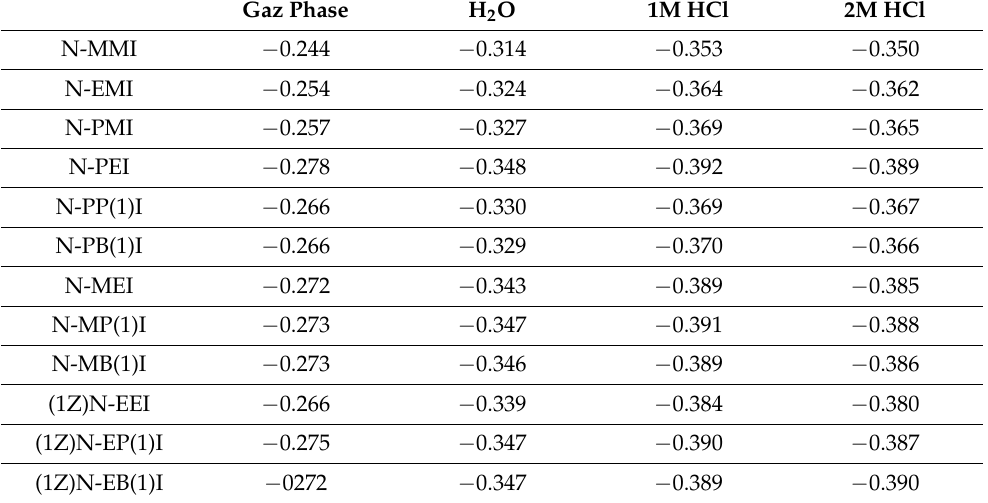
Table 2. Partial charges of the N atoms of the aliphatic Schiff bases under study determined by Mulliken population